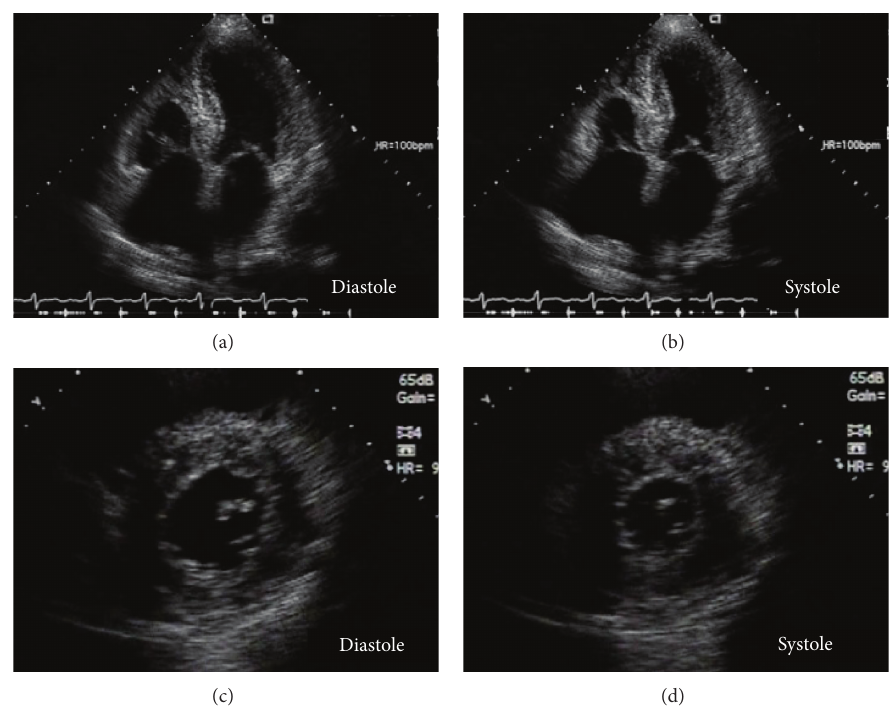
Figure 2: Transthoracic echocardiography 4-chamber (a and b) and short axis (c and d) views show concentric left ventricular (LV) hypertrophy, with a sparkling and granular myocardial texture; right ventricular hypertrophy; and bilateral atrial dilatation. The LV ejection fraction is preserved at 53%, and the mass significantly increased to 256.6